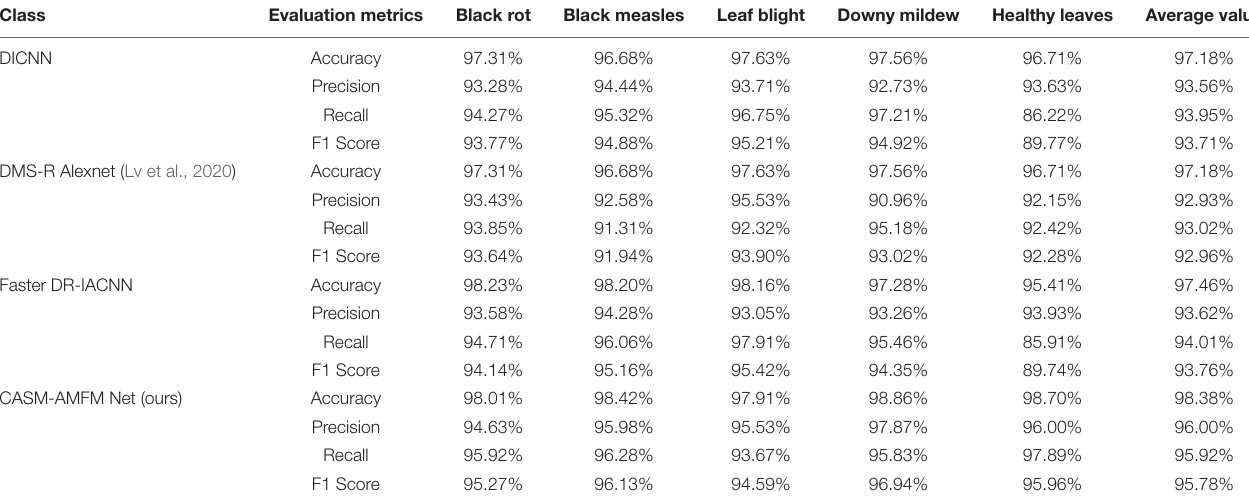
TABLE 12 | Performance evaluation of four types of networks.